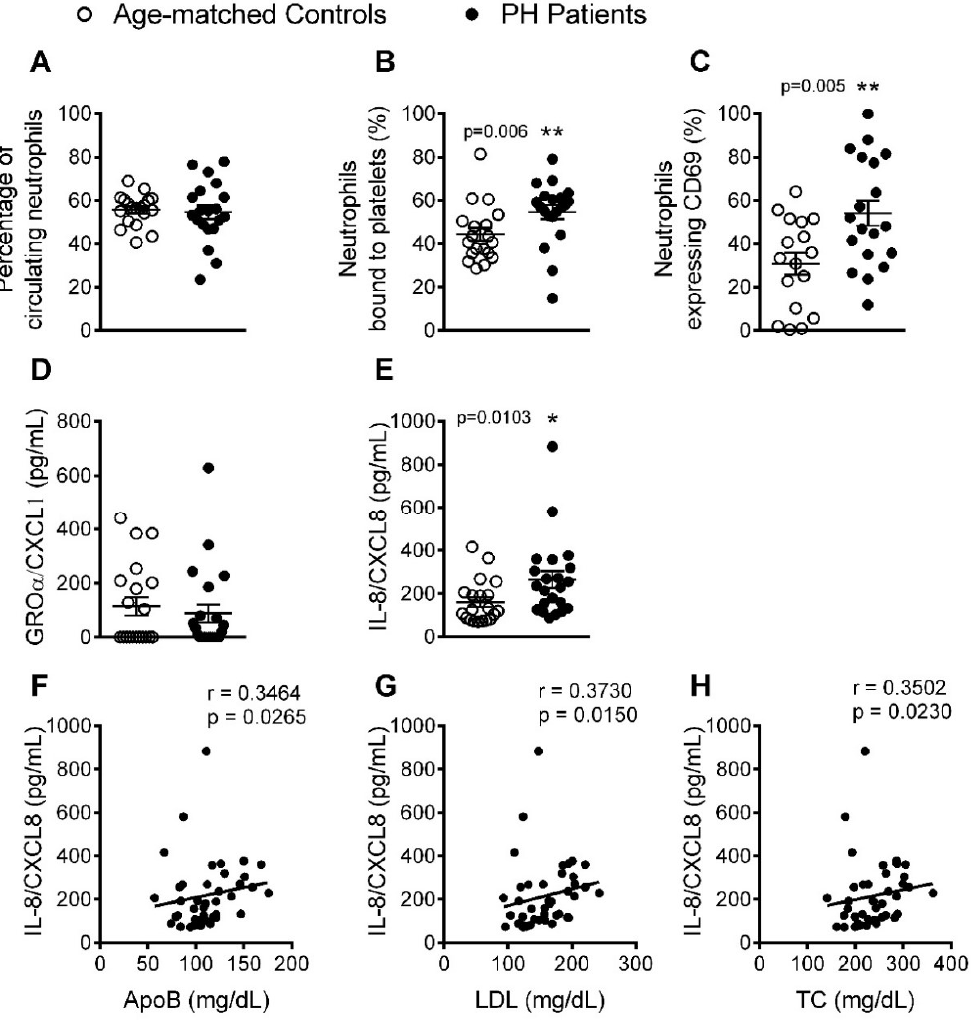
Figure 2. The percentage of platelet-neutrophil aggregates and activated neutrophils, and IL-8 circulating levels, are higher in patients with PH. Flow cytometry analysis of heparinized whole blood co-stained with specific markers for platelets and neutrophils ( A and B ). Neutrophils were also stained for CD69 ( C ). Results are expressed as percentage of positive cells. GRO α /CXCL1 ( D ) and IL-8/CXCL8 ( E ) plasma levels (pg/mL) were measured by ELISA ( n = 21 control subjects and n = 22 PH patients). Values are expressed as mean ± SEM. * p < 0.05 or ** p < 0.01 relative to values in the control group. Correlations between circulating IL-8 and ApoB ( F ), LDL ( G ) and TC ( H ) plasma levels.